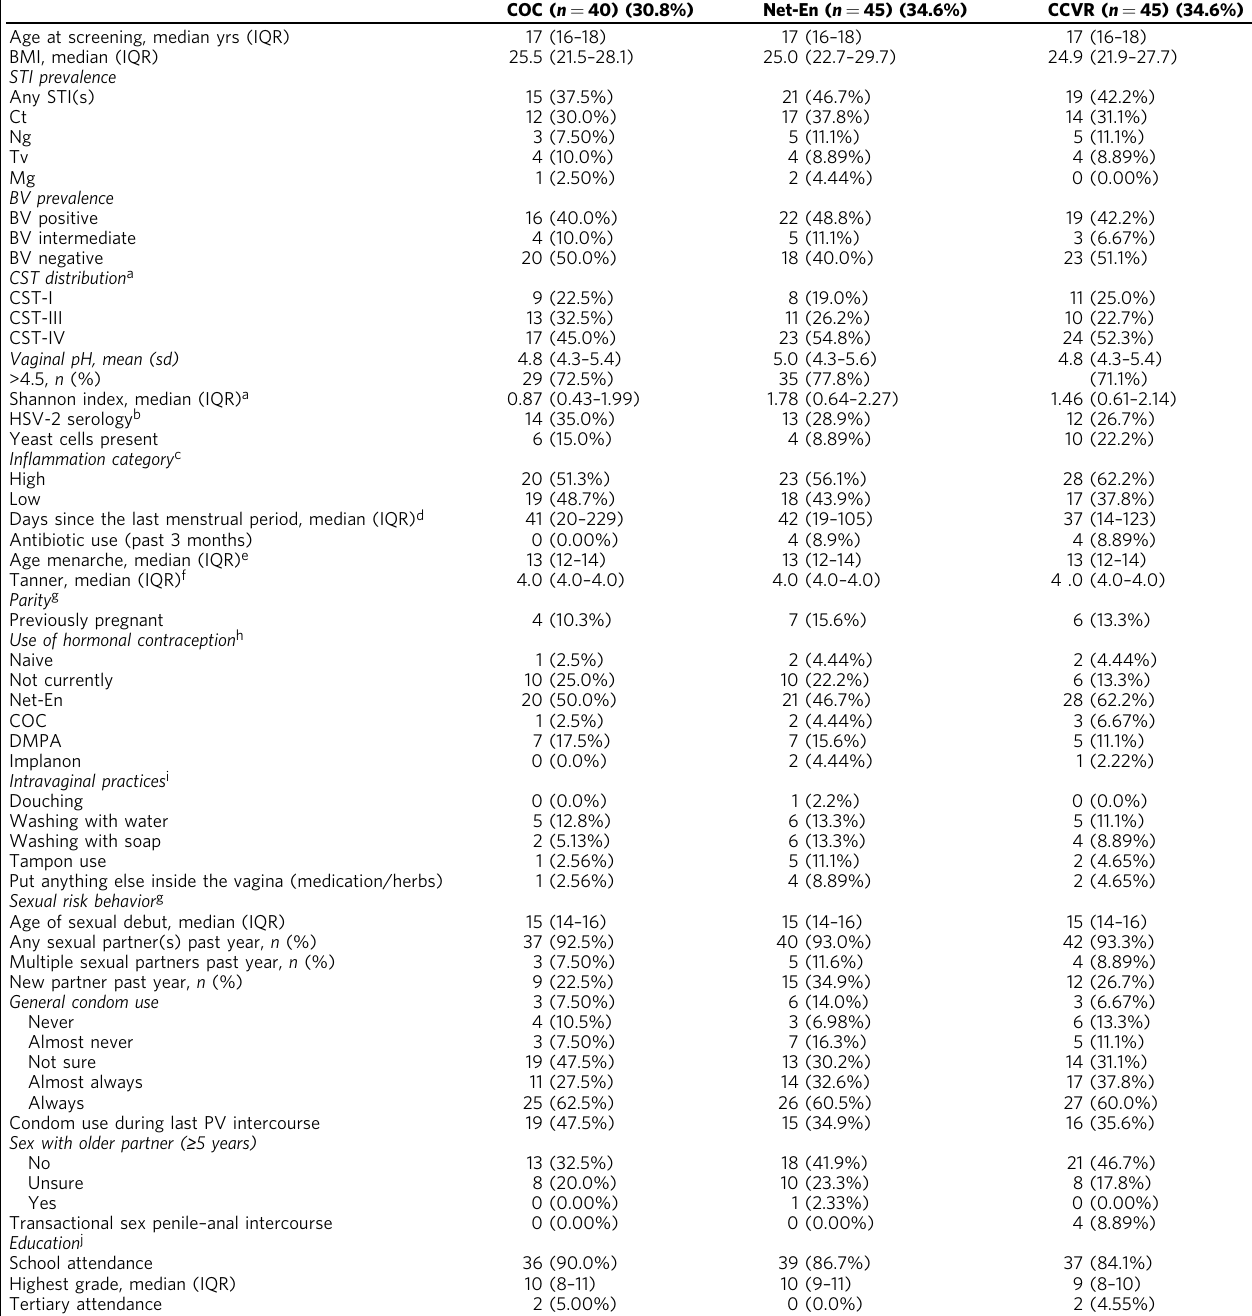
Table 1 Characteristics of participants at baseline according to randomization